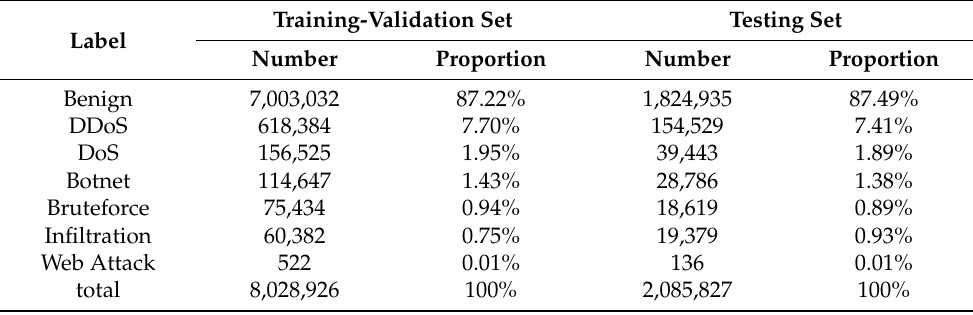
Table 5. CSE-CIC-IDS2018 multi-class classification of training-validation and testing